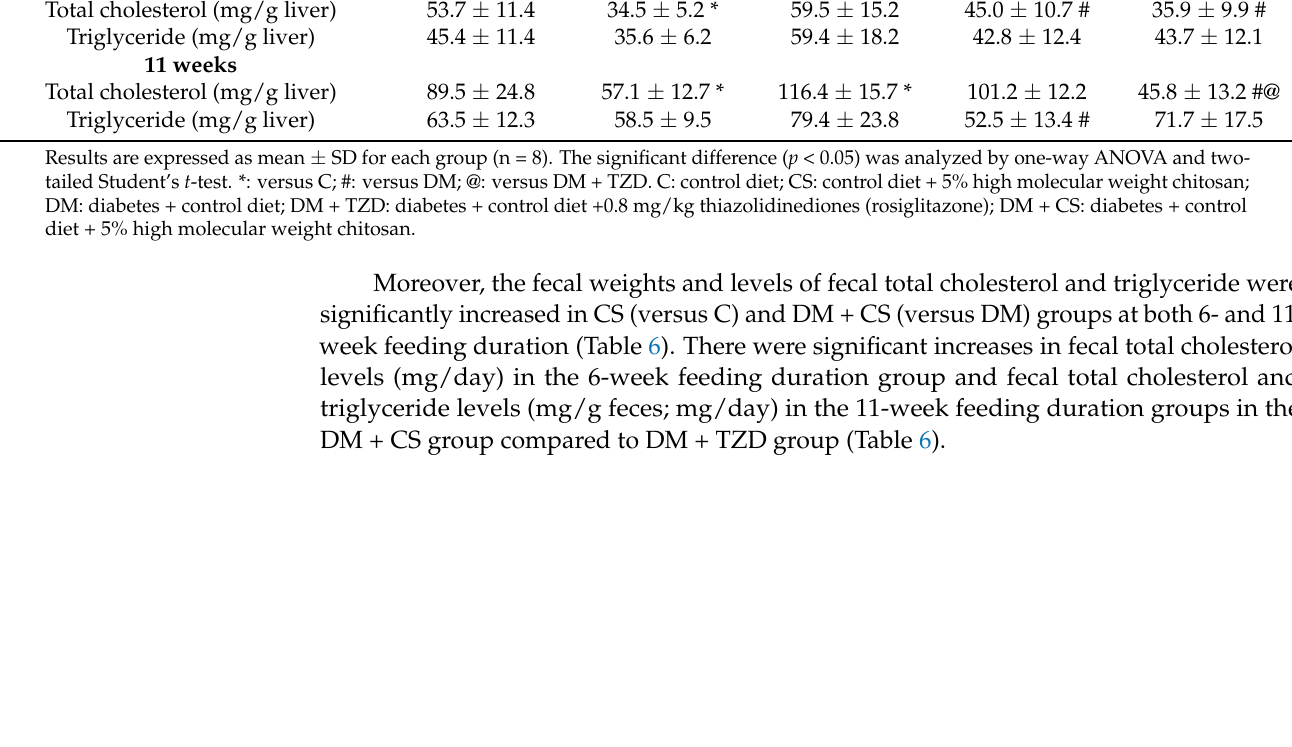
Table 5. The changes of hepatic lipid profiles in SD rats fed different experimental diets for 6 and 11 weeks. Diet C CS DM DM + TZD